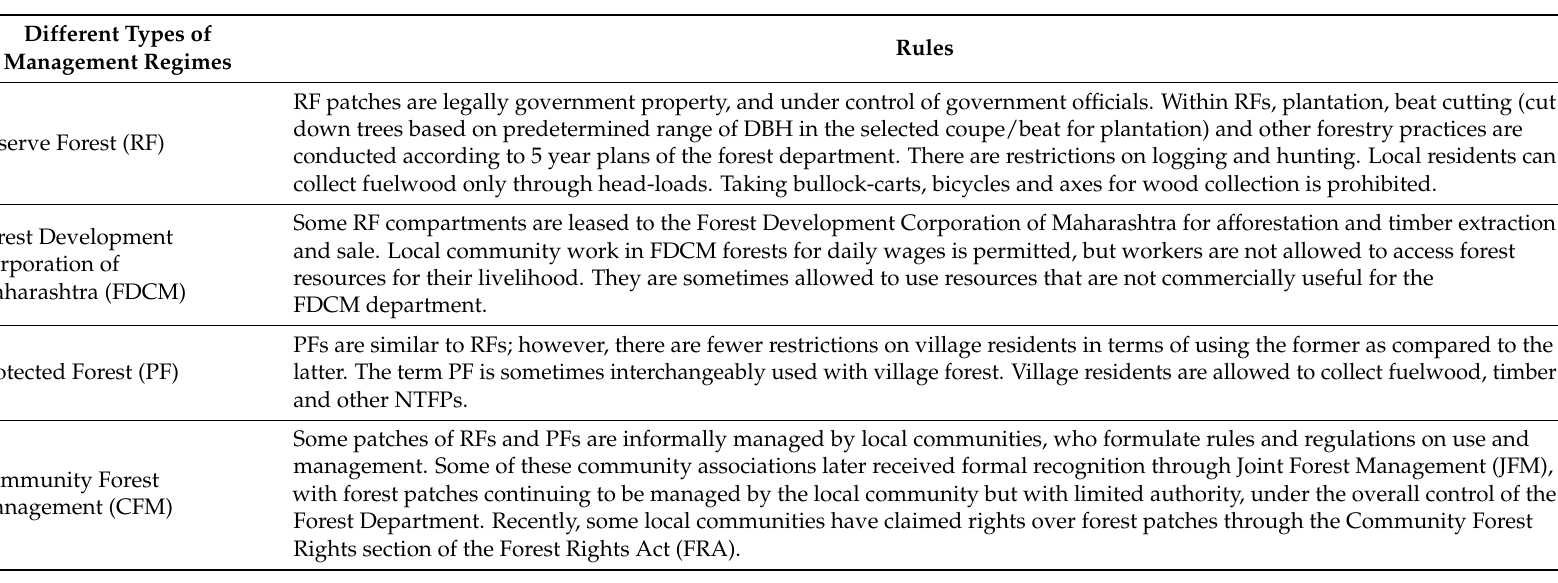
Table 1. Types of forest management regimes outside protected areas, with a description of rules governing use and access to forest